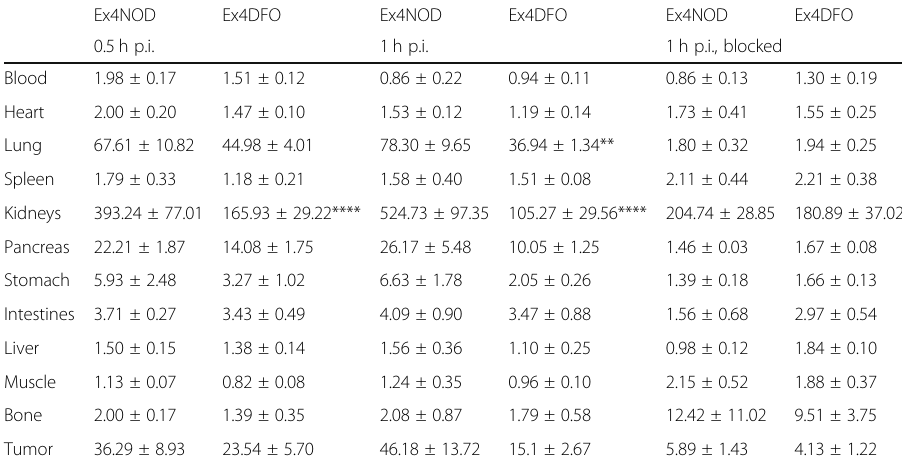
Table 1 Full timecourse biodistribution study of gallium-68 labeled Ex4NOD and Ex4DFO, given as percent injected activity per gram tissue (% i.A/g) Ex4NOD Ex4DFO Ex4NOD Ex4DFO Ex4NOD